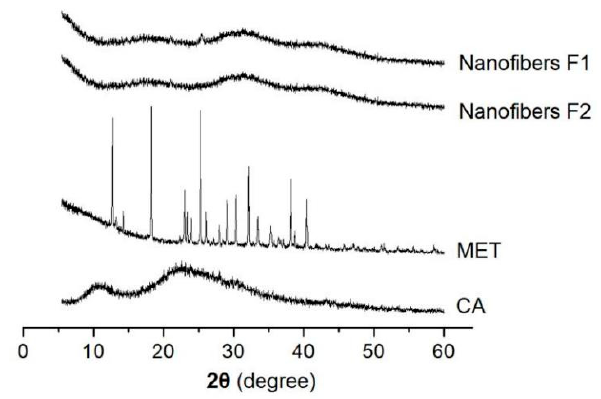
Figure 6. XRD patterns of CA, MET, and their core–sheath nanofibers F1 and F2.